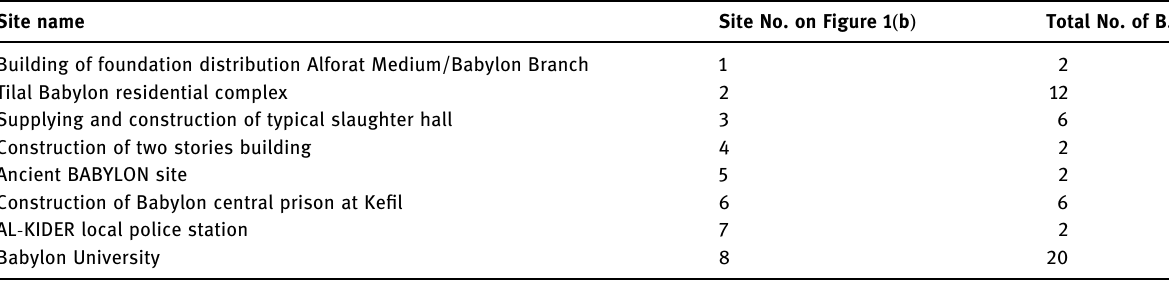
Table 1: Summary of sites and soil reports Site